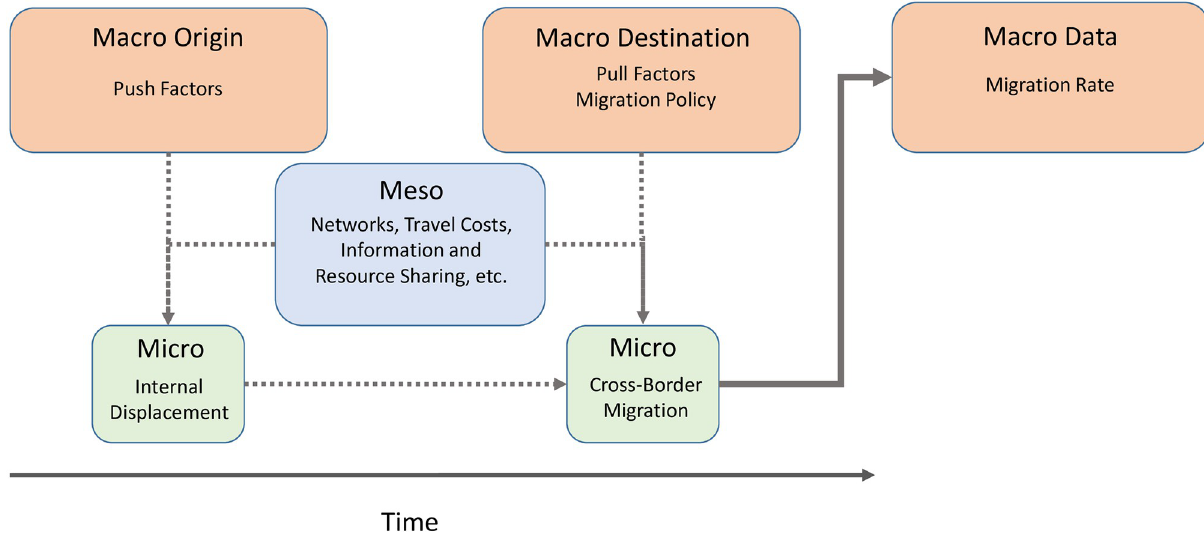
Fig 1. Forced migration process, drivers, and data source: Authors’ adaption based on previous studies [32–34].